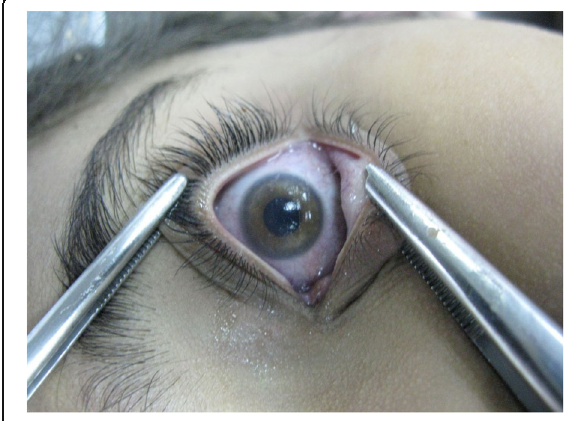
Fig. 3 The left eye with conjunctiva. No congestion or hemorrhages in